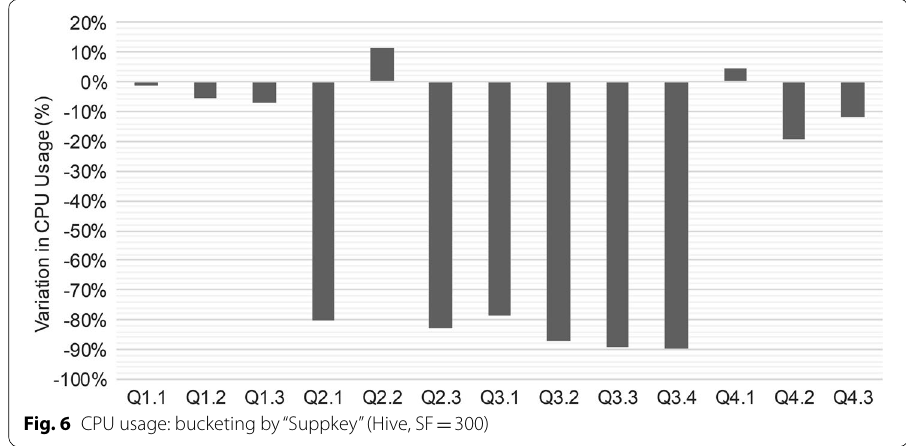
Fig. 6 CPU usage: bucketing by “Suppkey” (Hive, SF